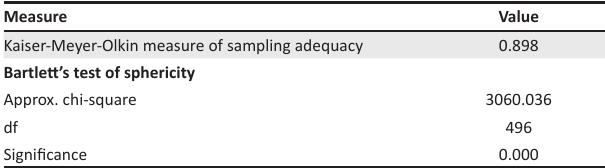
TABLE 1: Respondents’ profile. TABLE 2: KMO and Bartlett’s